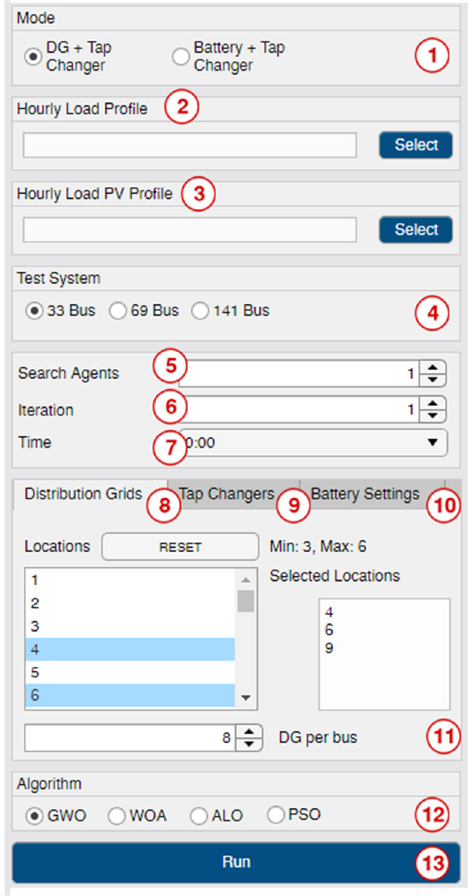
Figure 4. Settings panel of the toolbox.